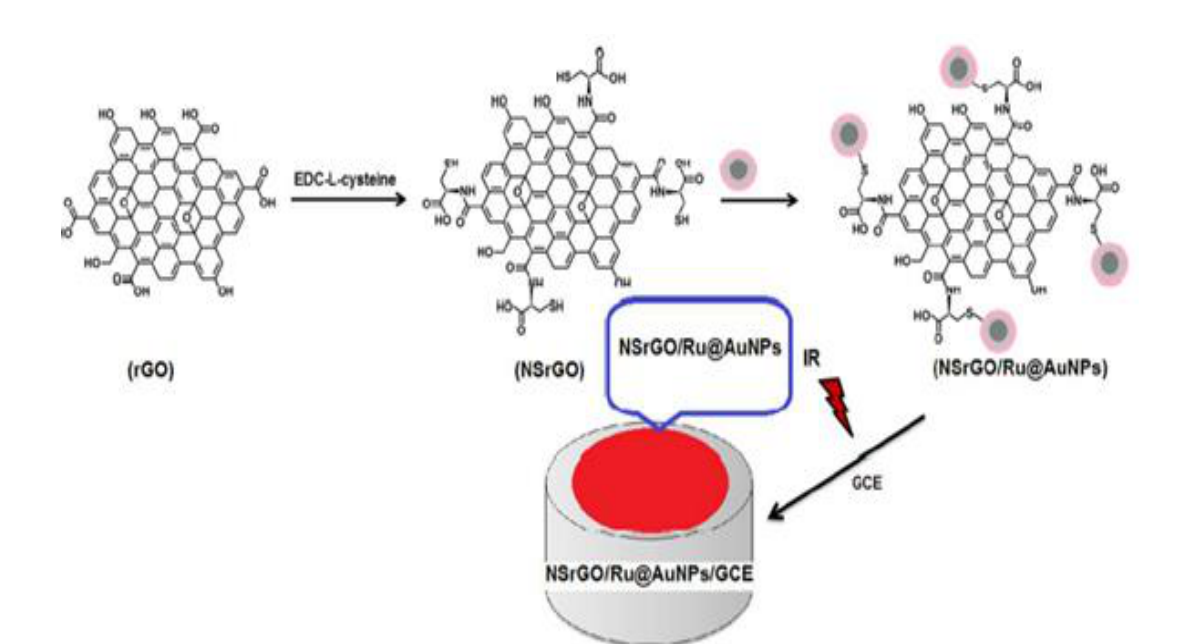
Figure 15. Schematic representation of the synthesis of L -cystein/rGO/Ru@AuNPs. Taken from Kotan et al . [220].